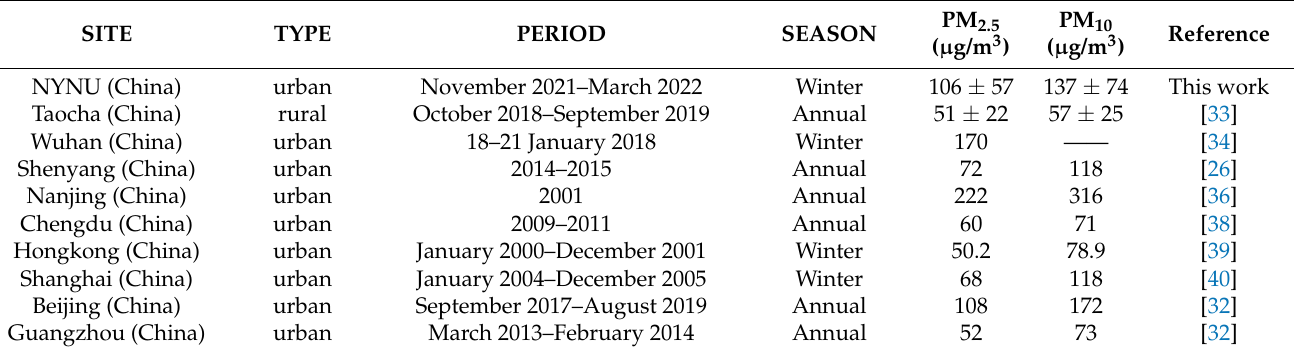
Table 3. Comparison of particulate matter mass concentration between NYNU station and other regional